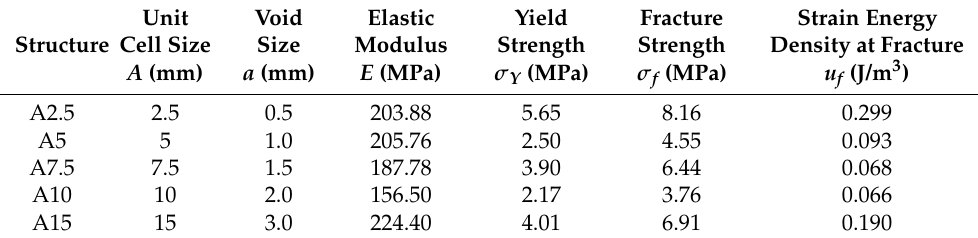
Table 1. Mechanical properties of test structures with n = 3 and A / a = 5.